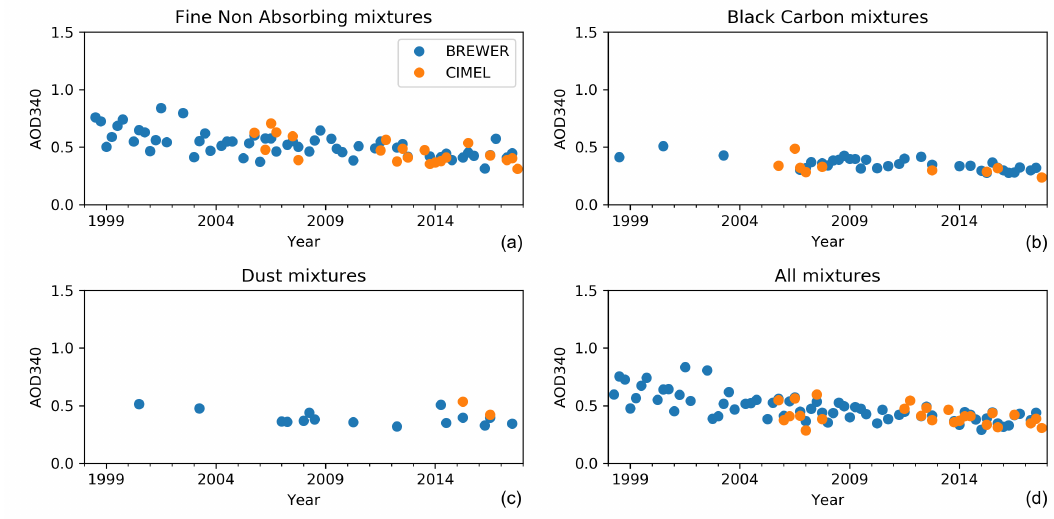
Figure 7. Seasonal timeseries of the AOD340 obtained from the Brewer (blue) and the CIMEL (orange). BC and DUST mixtures seem to appear more frequently after 2007 in the Brewer timeseries. It is not clear, however, whether this is due to a general lower data availability early in the timeseries or it is a a real shift towards a more frequent occurrence of these two types. To verify that, we calculated the occurrence ratio per aerosol type which we define as the number of flags of the specific type within a time interval divided by the total number of flags in the same interval. Similar to the AOD timeseries, daily values of the occurrence ratio are produced first from the hourly values. Then, weekly averages are calculated from daily averages when at least 2 daily averages are available, monthly averages from weekly averages when at least 2 weekly averages are available, and seasonal averages from monthly averages when at least 1 monthly value